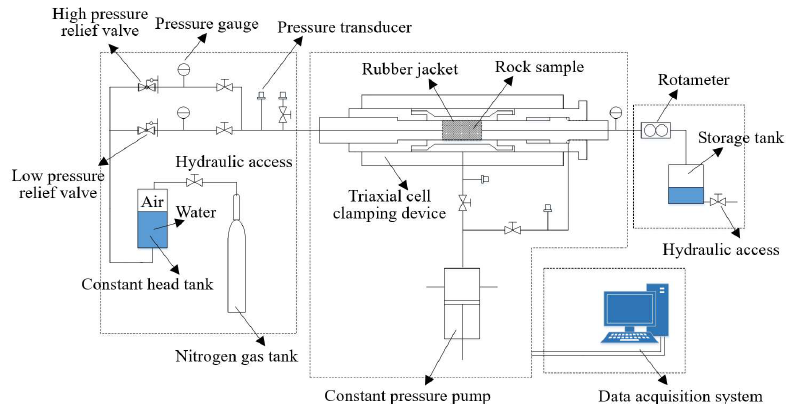
Figure 2. Schematic diagram of the rock permeability test system.